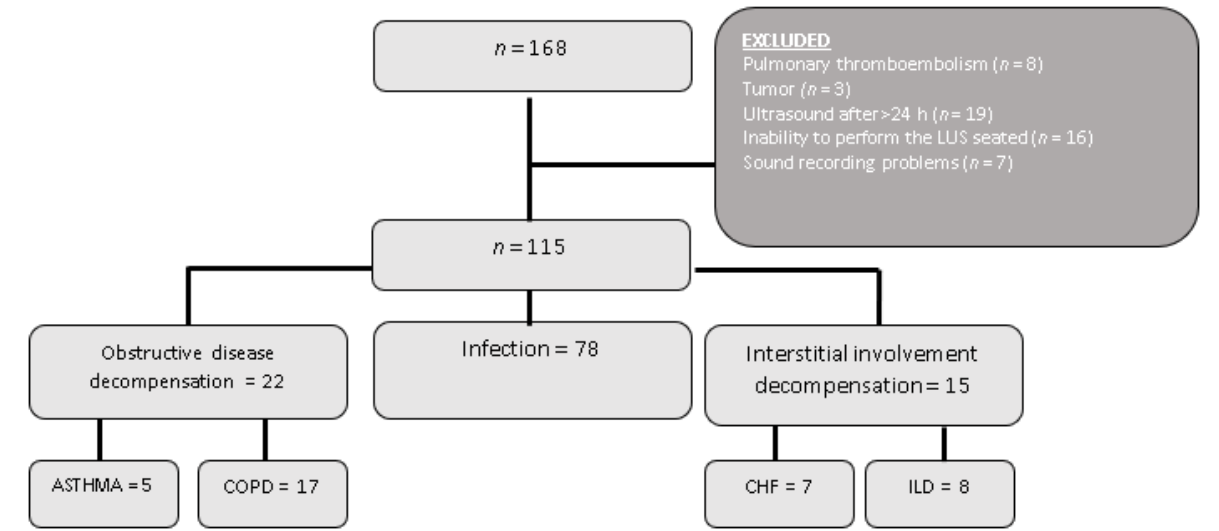
Figure 1. Flow chart. ILD = interstitial lung disease, CHF = Congestive Heart failure, COPD: Chronic obstructive pulmonary disease.